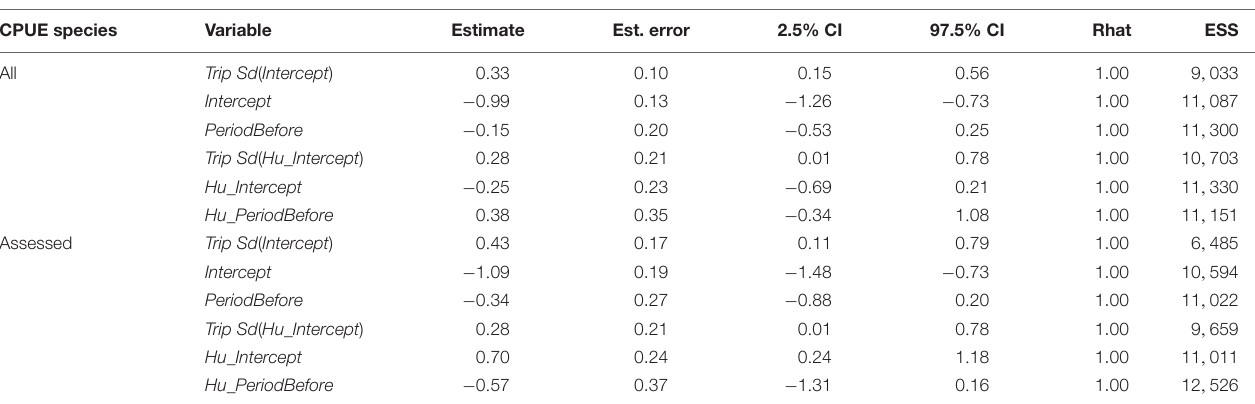
TABLE 7 | Results from the Period + Trip hurdle model for predicting reef fish CPUE. CPUE